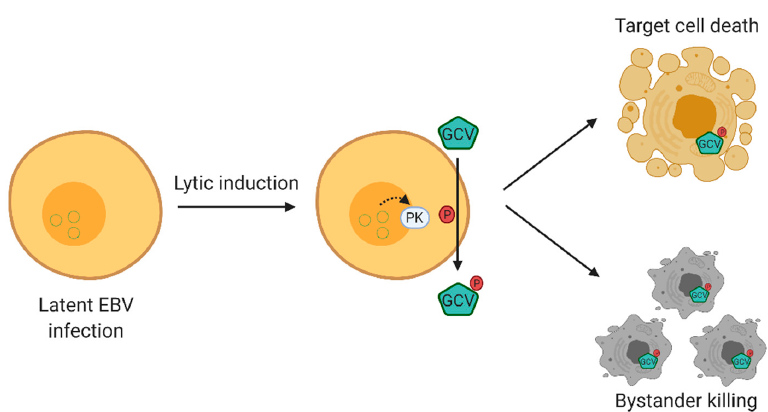
Figure 1. Overview of Epstein–Barr virus (EBV) lytic induction therapy. EBV lytic cycle is